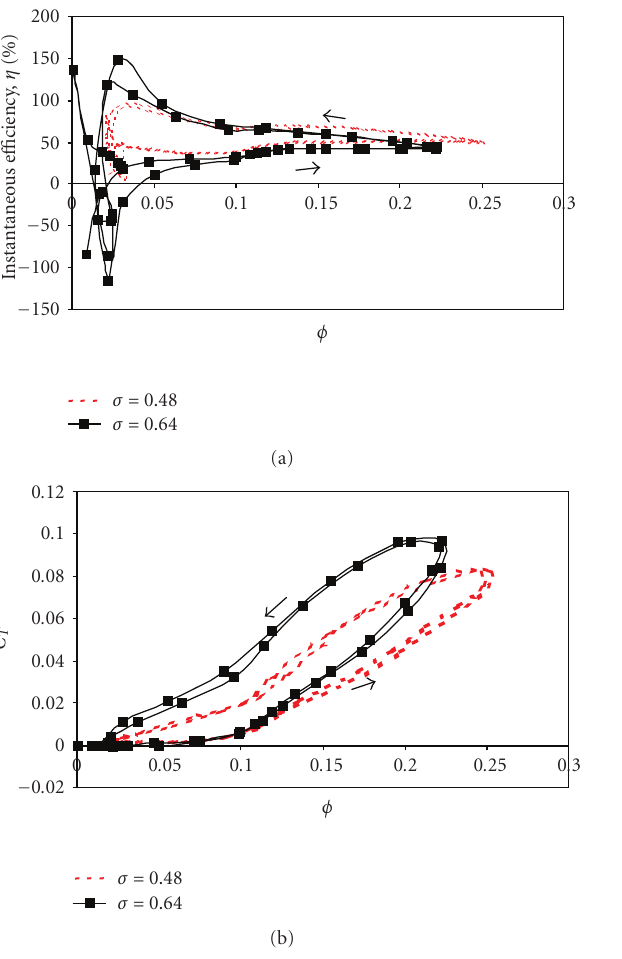
Figure 10: Variation of instantaneous e ffi ciency and torque coe ffi - cient of CA9 with σ = 0.48 and σ = 0.64 at value 1 /κω ∗ = 0 . 2: (a) e ffi ciency, (b) torque coe ffi cient.